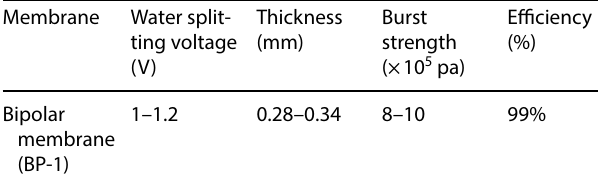
Table 2 The properties of bipolar membrane Membrane